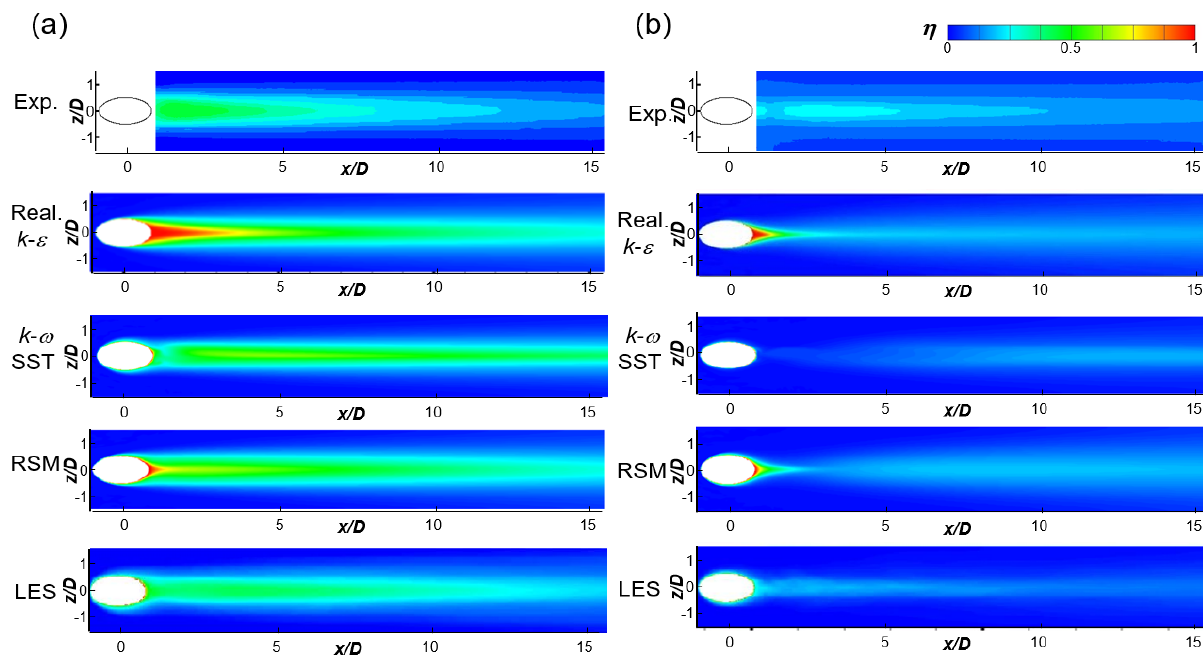
Figure 4. Boundary layer temperature distributions in the streamwise normal planes [5]: ( a ) x / D = 2.5, M = 0.5; ( b ) x / D = 5.0, M = 0.5; ( c ) x / D = 10.0, M = 0.5; ( d ) x / D = 2.5, M = 1.0; ( e ) x / D = 5.0, M = 1.0; and ( f ) x / D = 10.0, M = 1.0.